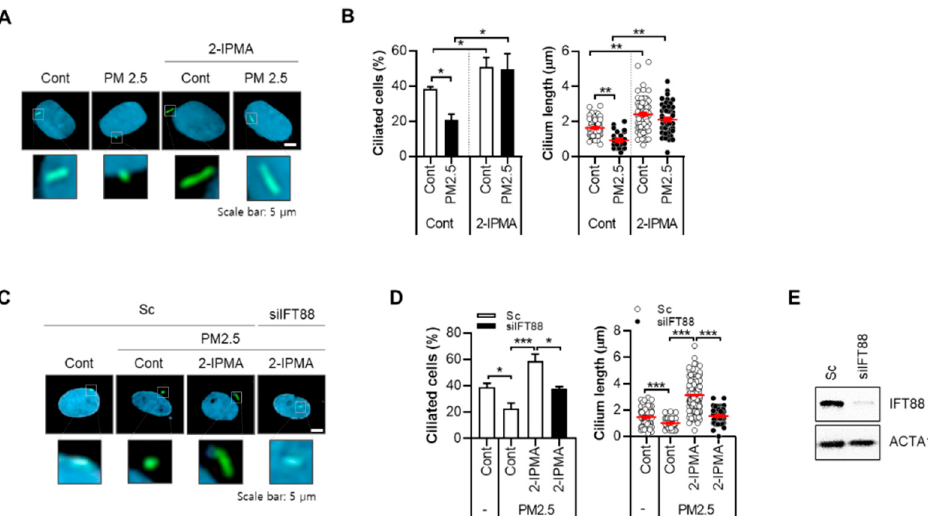
Figure 2. 2-IPMA restores PM2.5-mediated ciliary dysgenesis in normal dermal fibroblasts. ( A , B ) Normal skin fibroblasts were treated with PM2.5 (50 μ g/mL) for 24 h in the presence or absence of 2-IPMA (100 μ M) for 24 h. ( A ) Then, the cells were imaged by immuno-staining with ARL13B antibody (green) and Hoechst dye (blue) Scale bar: 5 μ m. ( B ) The ciliated cells and cilium length of the cells were measured under a fluorescence microscope. ( C – E ) Normal dermal fibroblasts transfected with either scrambled siRNA (Sc) or targeted siRNA to IFT88 (si IFT88 ) were treated with PM2.5 (50 μ g/mL) with or without 2-IPMA (100 μ M) for 24 h. ( C ) Then, the cells were imaged by immuno-staining with ARL13B antibody (green) and Hoechst dye (blue), scale bar: 5 μ m. ( D ) The ciliated cells and cilium length of the cells were measured. ( E ) The reduced expression of IFT88 by siRNA was analyzed by Western blotting. Data are presented as the mean ± SEM ( n = 100, * p < 0.05, ** p < 0.01, *** p < 0.005).